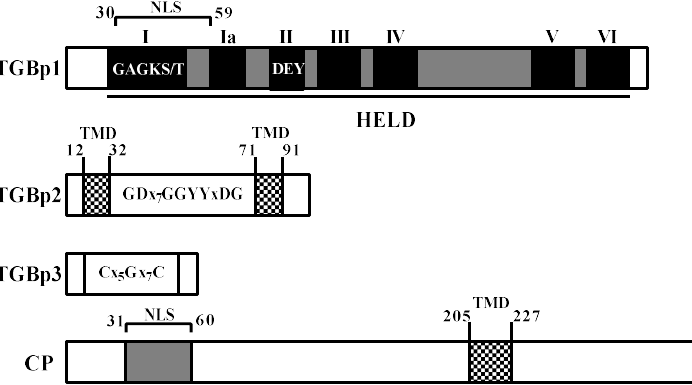
Figure 1. Sequence analysis of CYVCV proteins. The ‘HELD’ in TGBp1 referred to a helicase-like domain, and the numbers (I, Ia, II, III, IV, V, and VI) at the tops of dark boxes referred to seven